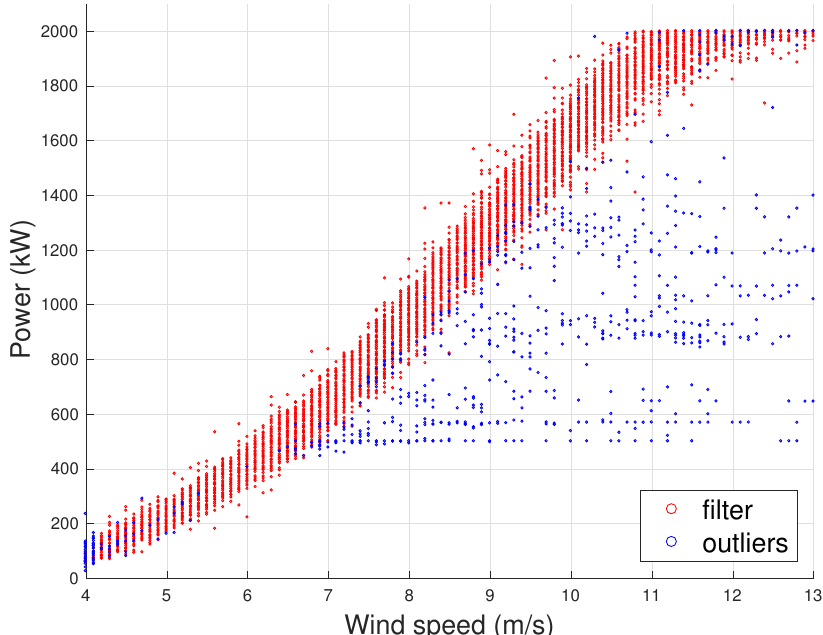
Figure 1. An example of scattered power curve before and after data